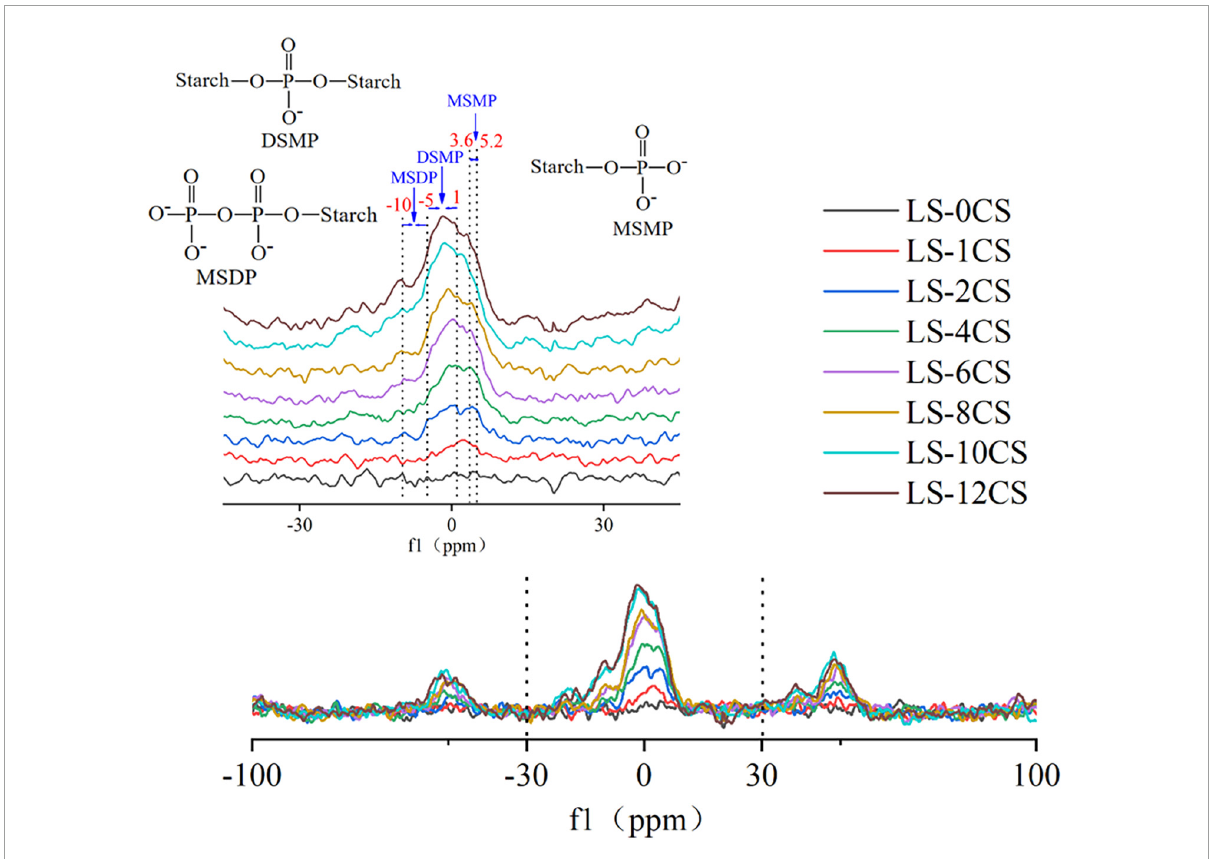
FIGURE6 31 P NMR of lotus seed cross-linked resistant starch